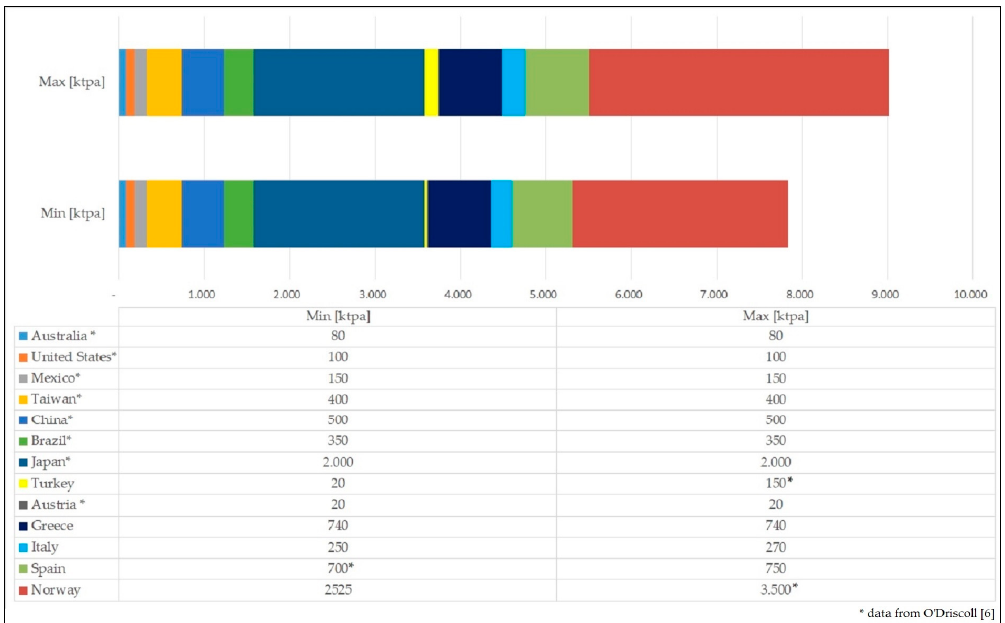
Figure 2. World production of peridotite (Current numbers for the production from the producers of the investigated samples (Figure 1); *: Data from O’Driscoll [6]).